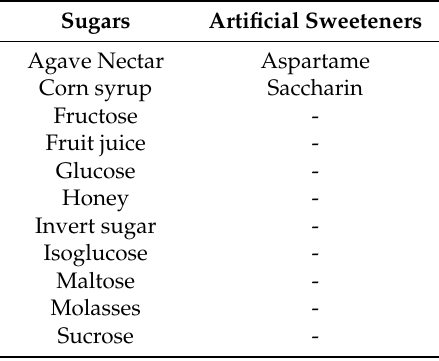
Table 1. Sugars and artificial sweeteners that were classified by